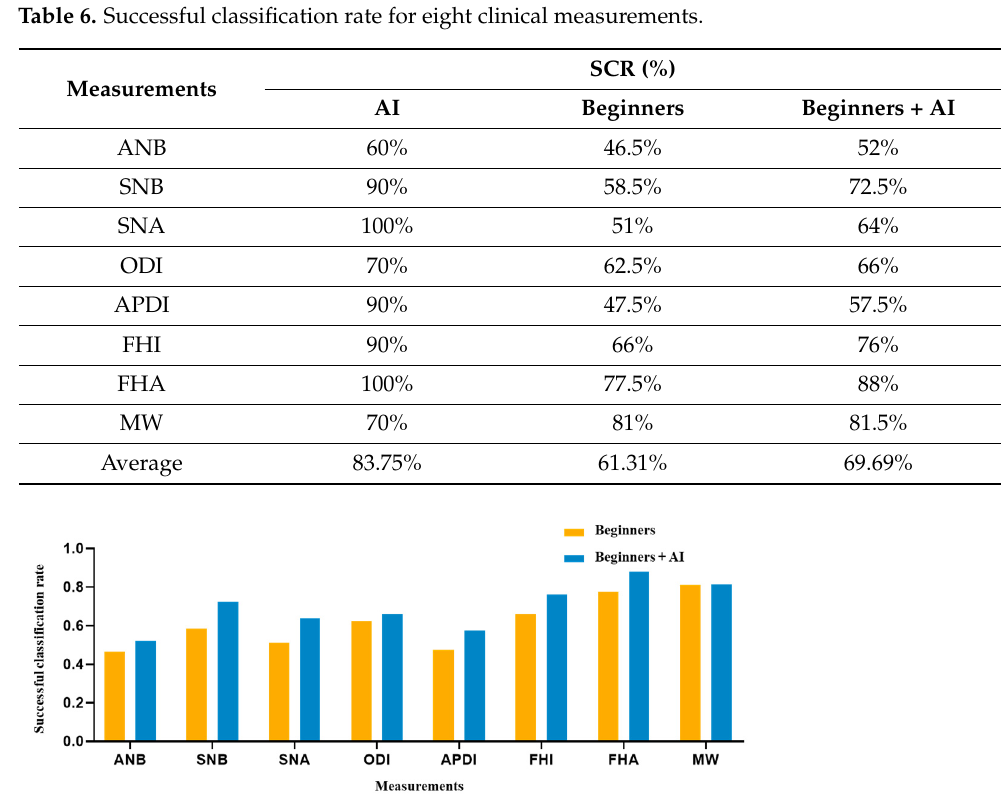
Figure 5. Comparison of eight clinical measurements between the beginner-only and beginner–AI groups. From the SCRs of two groups, a figure was presented to demonstrate the AI’s support. As a result, the beginner–AI collaboration improved the SCRs of eight clinical measurements. Abbreviation: SCR, successful classification rate.